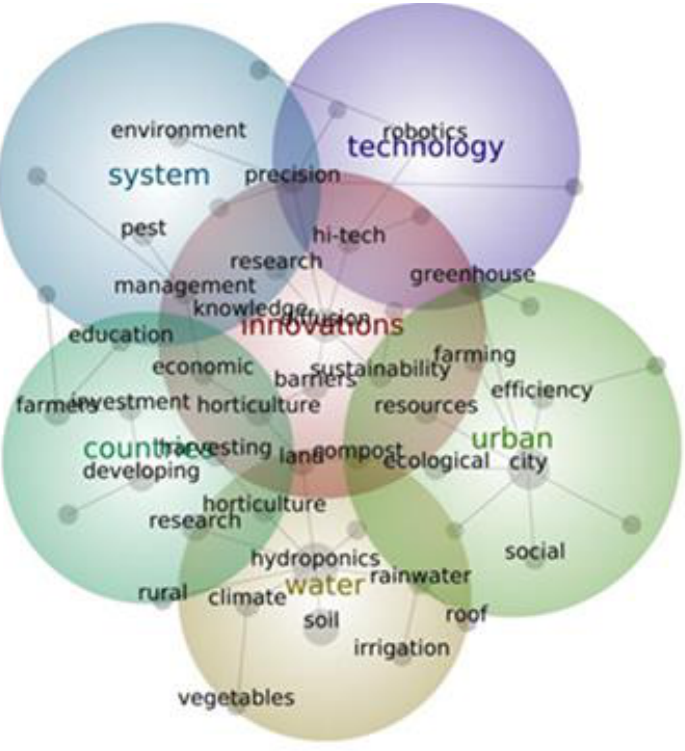
Figure 8. Leximancer concept map. The theme size is set to 52%.